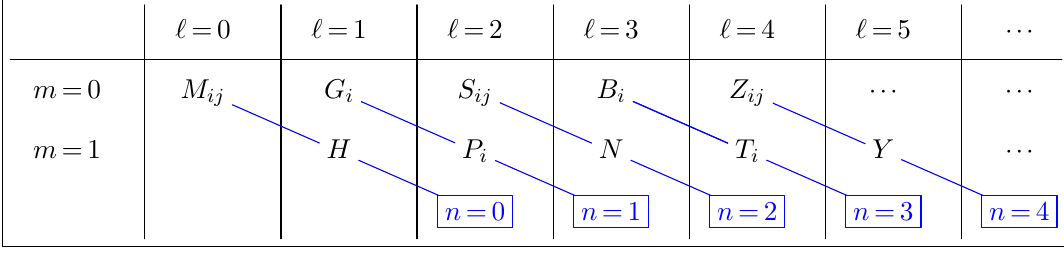
Table 3 . The extension of the algebra in [20] with one more diagonal level [21].